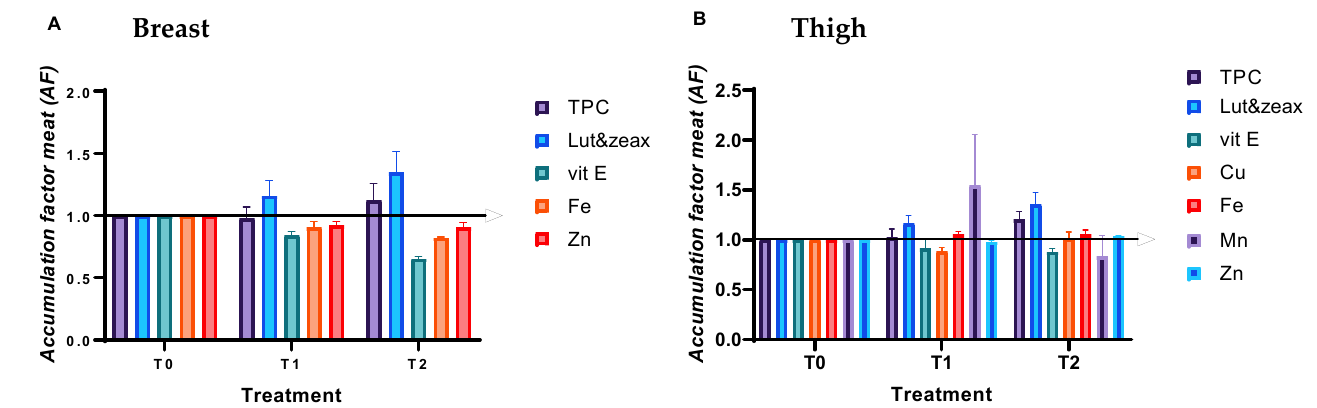
Figure 2. Bioactive nutrients accumulation factors (AF) in chicken breast ( A ) and thigh ( B ) under the influence of different treatments (error bar represents a range of 95% confidence). T0: control diet; T1: treatment with 0.00002% Cr; and T2: experimental diet supplemented with 0.00002% Cr +2% sea buckthorn leaves (SBL).